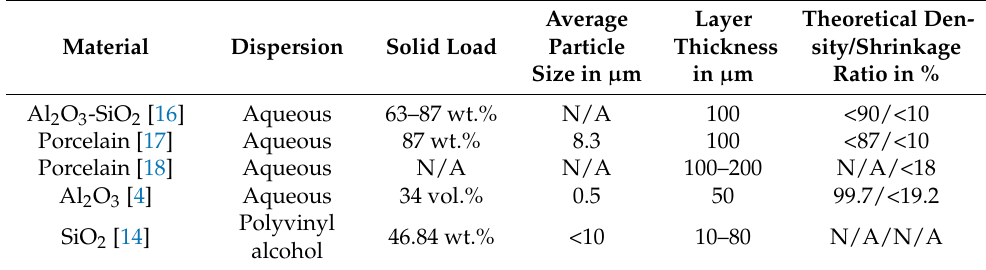
Table 1. Overview of Exemplary Studies Conducted within Slurry-Based Additive